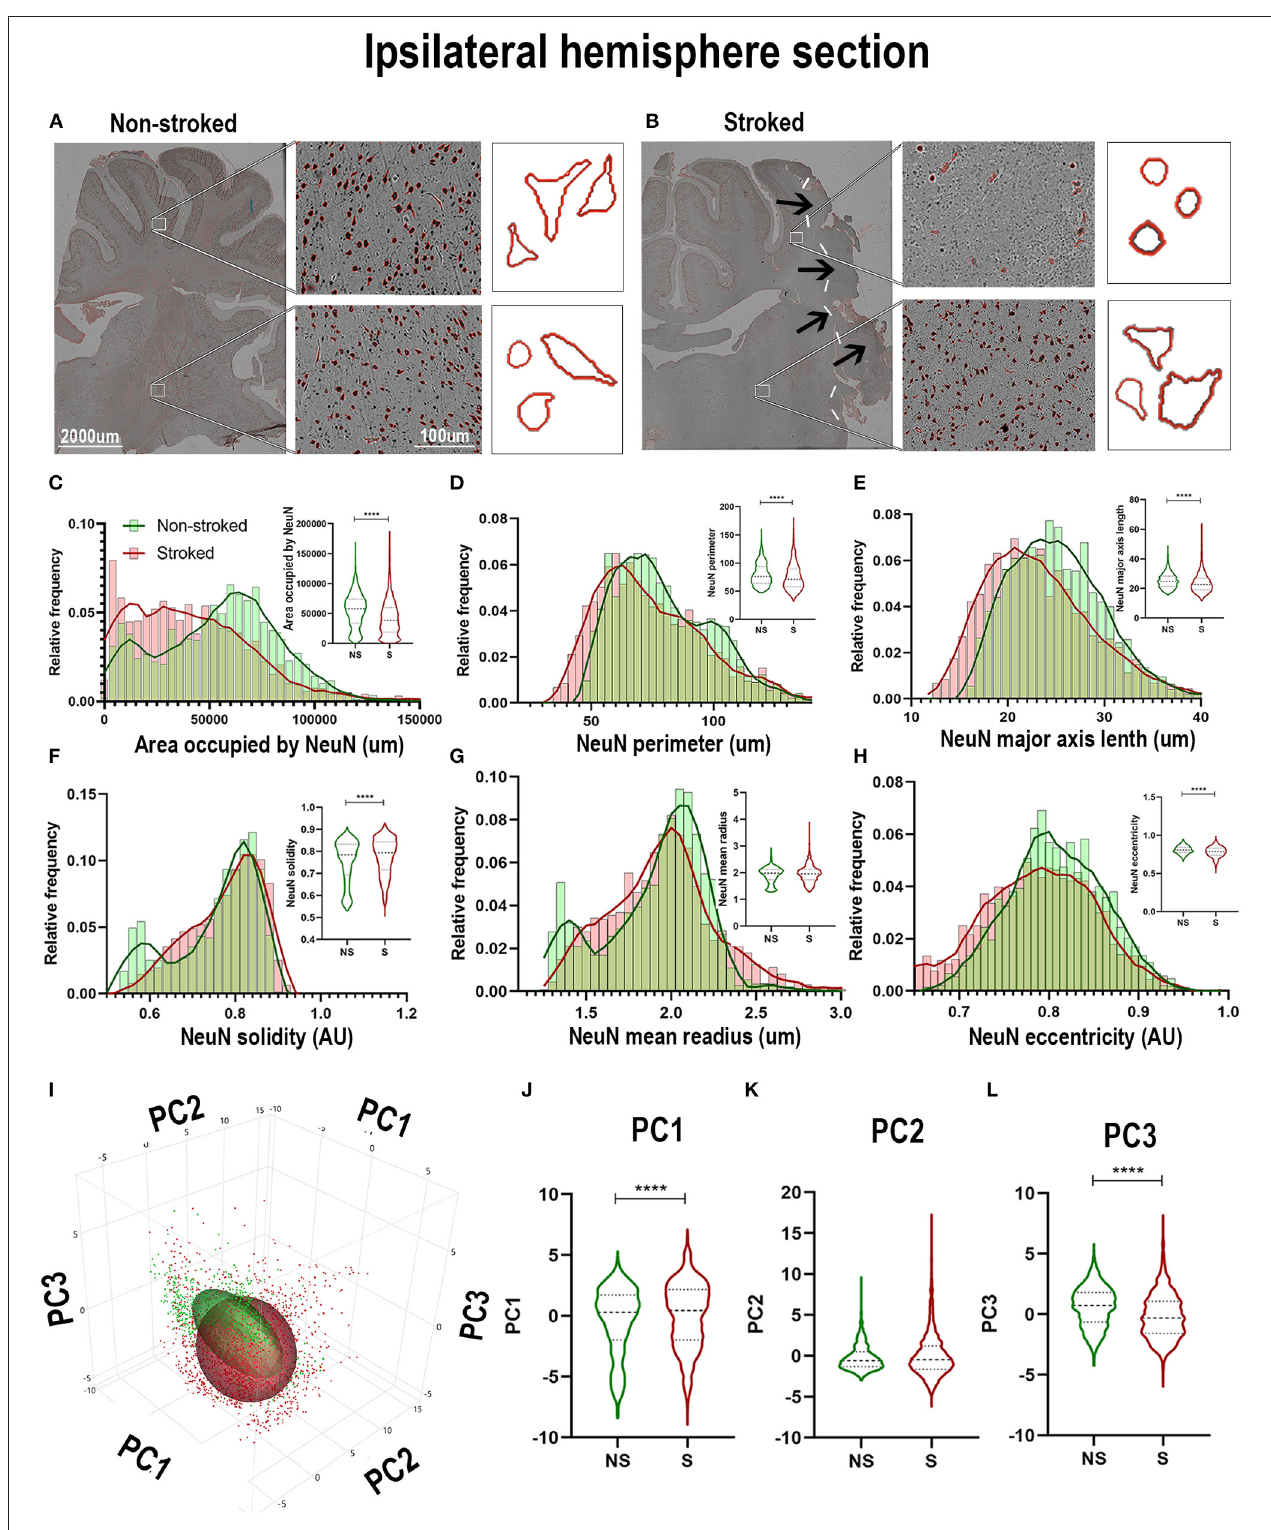
FIGURE 6 | NeuN + cells transitioned to a stressed phenotype after stroke in the ipsilateral hemisphere. Visual differences in density and location of NeuN + areas in ipsilateral hemispheric sections were observed between NS and S animals (A,B) . Arrows indicate location of stroke lesion (B) . Significant ( p < 0.0001) decreases in area occupied (C) , perimeter (D) , major axis length (E) , and eccentricity (H) were observed between ROIs of S ( n = 2,230 ROIs) compared to NS ( n = 1,476 ROIs)